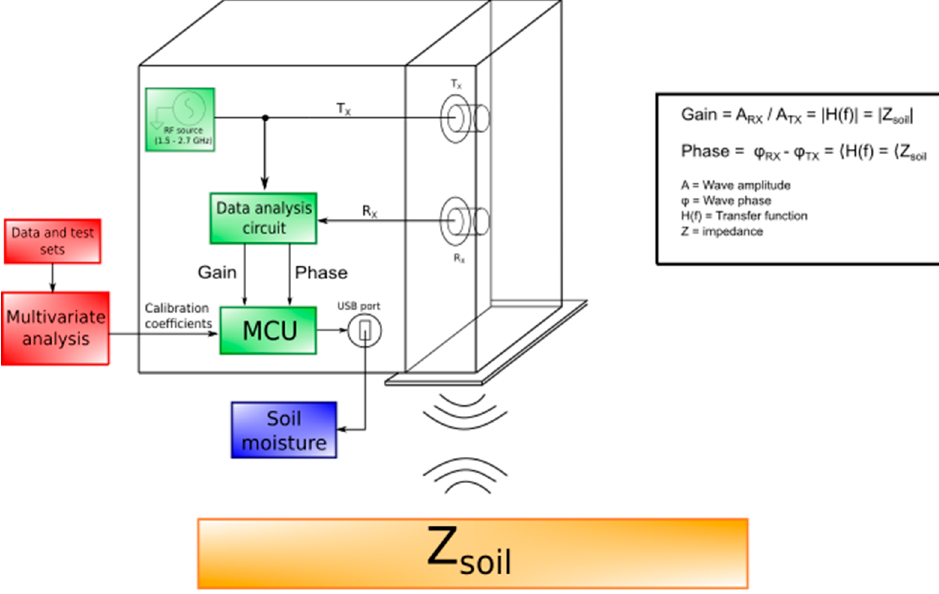
Figure 1. System general functioning. A data analysis circuit calculate “gain” and “phase” data, using as input transmitted and received electromagnetic waves. These data are used to calculate the soil moisture directly in the microcontroller unit (MCU), thanks to calibration coefficients obtained from a multivariate statistical analysis.